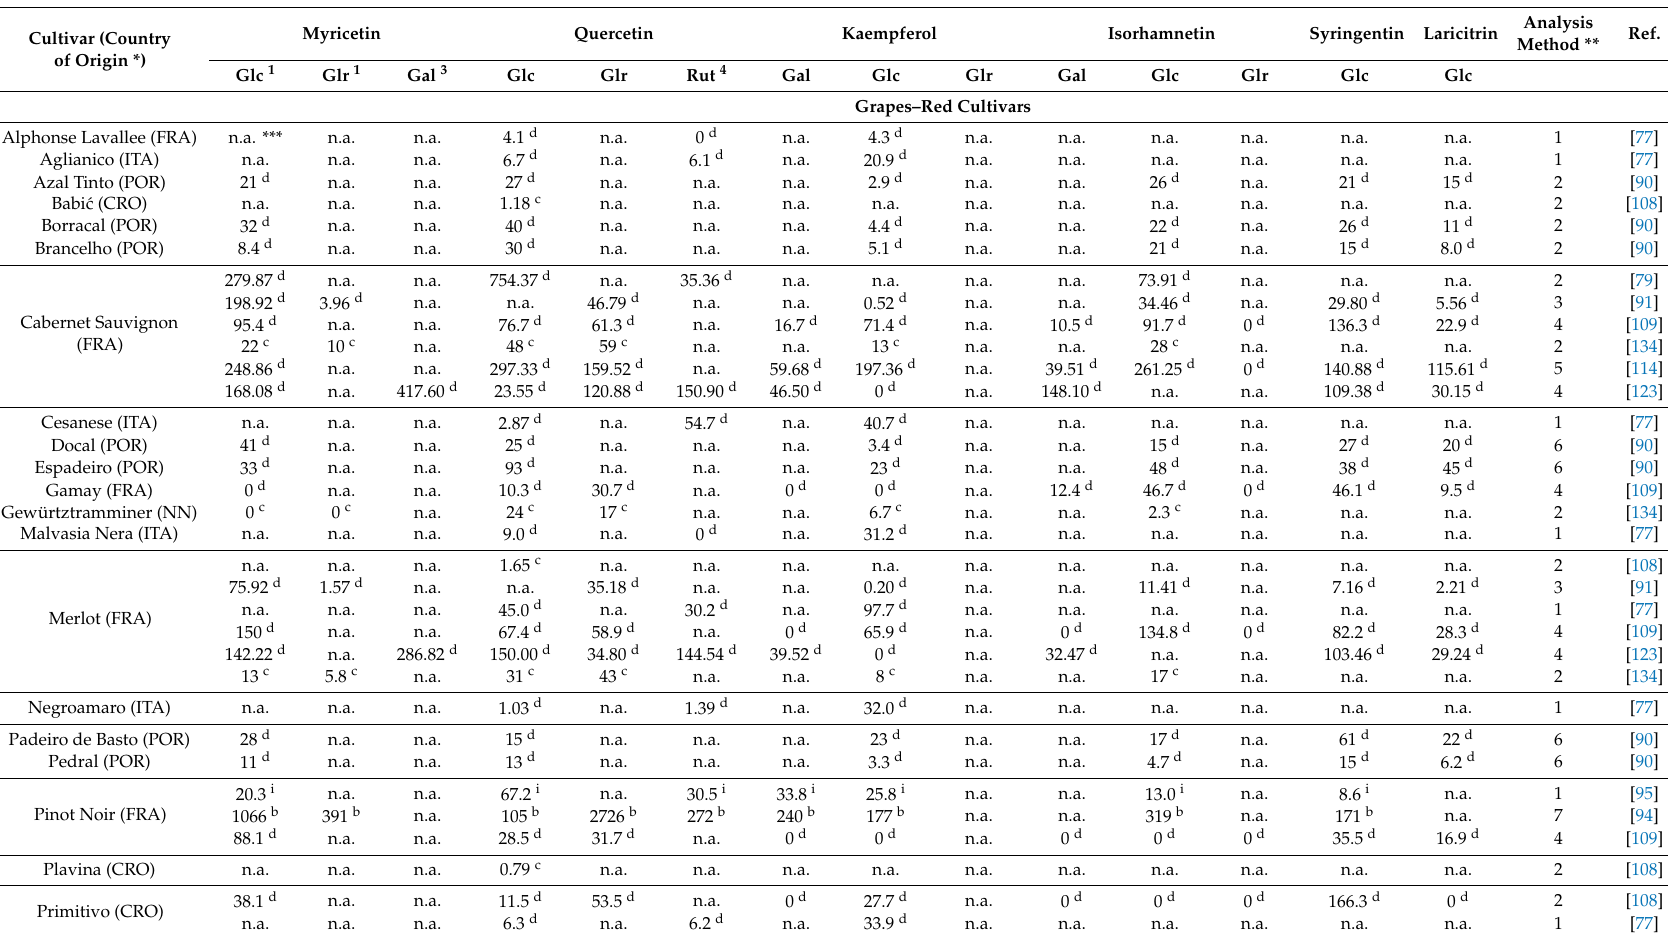
Table 5. Flavonol profiles of di ff erent grapevine